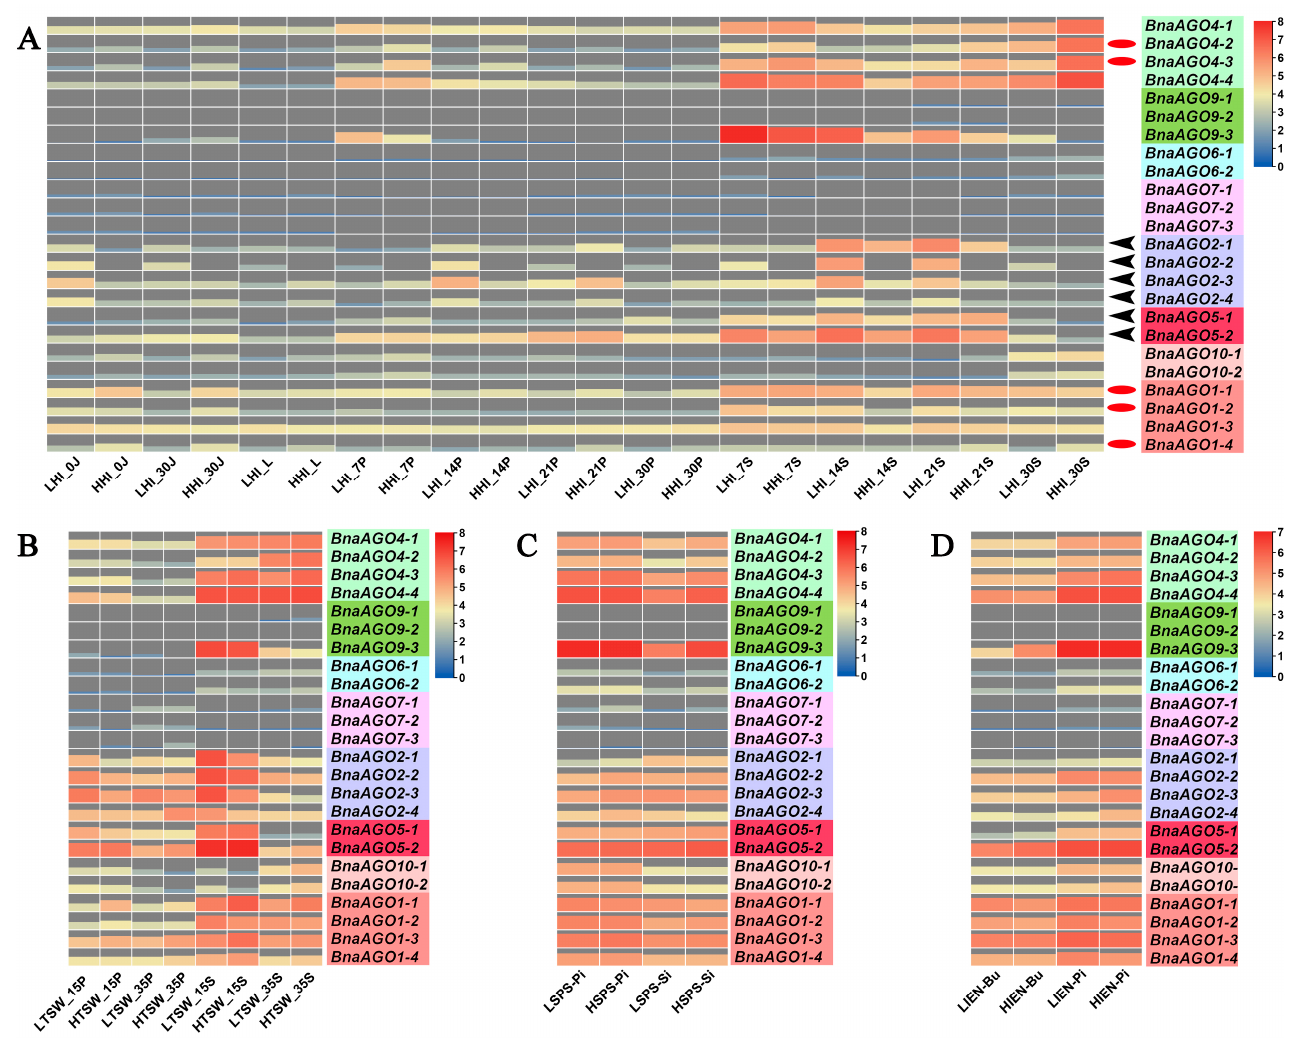
Figure 5. The expression level of the 24 identified BnaAGO s in yield-related materials with differences in harvest index (HI); ( A ), thousand-seed weight (TSW;) ( B ), seed number per silique (SPS); ( C ), and initial embryonic number (IEN;) ( D ). The numbers used in the labels on the x -axis (0, 7, 10, 14, 15, 20, 21, 30, and 35) indicate the day after flowering; LHI and HHI indicate high- and low-HI materials; LTSW and HTSW indicate high- and low-TSW materials; LSPS and HSPS indicate high- and low-SPS materials; LIEN and HIEN indicate high- and low-IEN materials; J: stem; L: leaf; Bu: bud; P: pericarp; S: seed; Pi: pistil; Si: